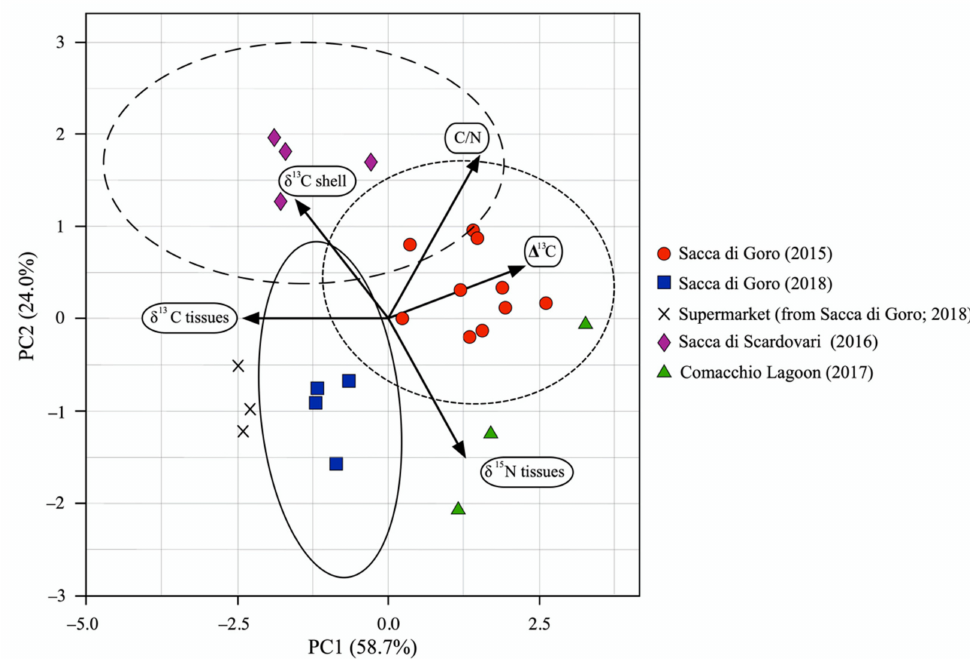
Figure 5. Principal component analysis (PCA) for the δ 13 C of shells, δ 13 C, δ 15 N and C/N of tissues and ∆ 13 C in manila clams collected onsite from north-western Adriatic lagoons and bought at a local